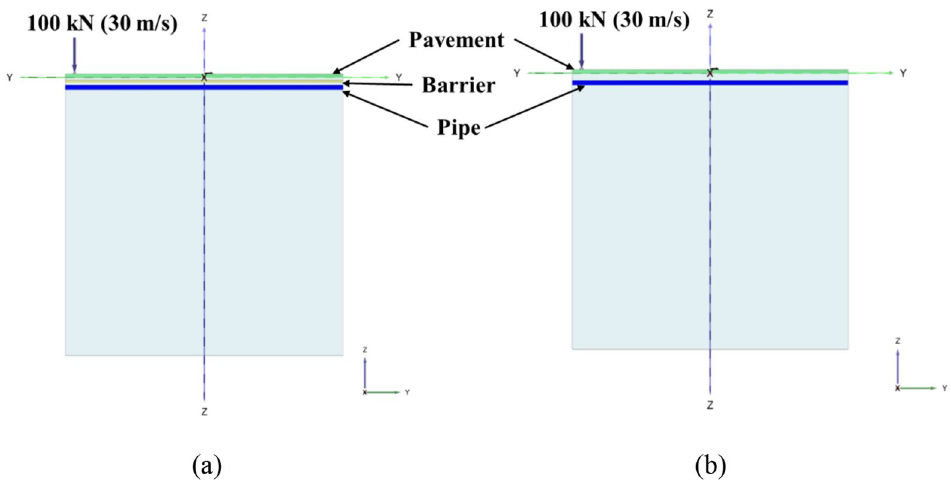
Figure 5. Cross-sectional view of ( a ) pipe with safeguard and ( b ) pipe without safeguard below road pavement subjected to 100 kN traffic load with moving speed of 30 m s −1